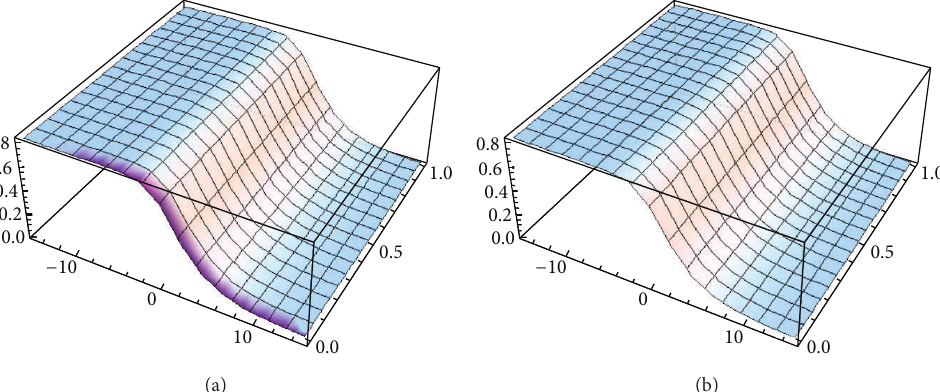
Figure 7: Graph of the solution (33) corresponding to the values 𝛼 = 0.05 , 𝛼 = 0.85 , respectively, when 𝑘 = 1 , 𝑝 = 3 , 𝛽 = −2 , −15 < 𝑥 < 15 , and 0 < 𝑡 < 1 .